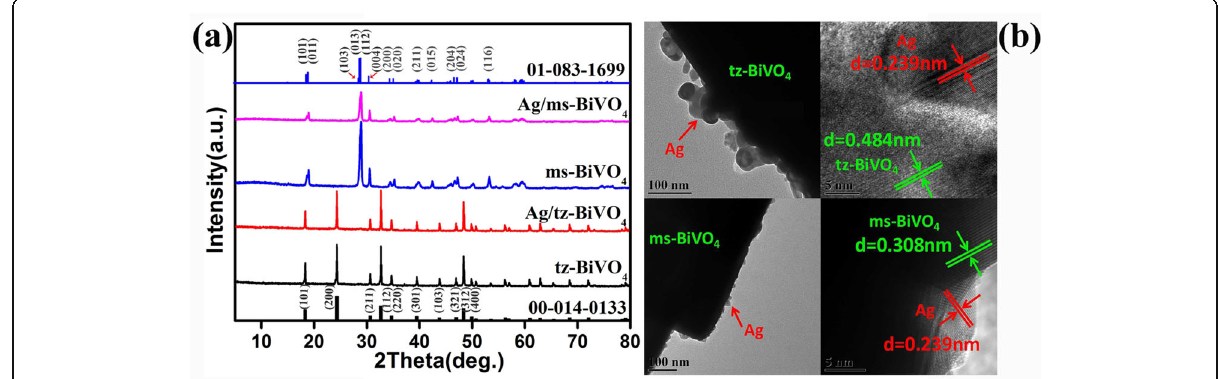
Fig. 1 a XRD patterns of pristine tz-BiVO 4 , Ag/tz-BiVO 4 sample, pristine ms-BiVO 4 , and Ag/ms-BiVO 4 sample. b TEM image of Ag/tz-BiVO 4 , HRTEM of Ag/tz-BiVO 4 , TEM image of Ag/ms-BiVO 4 , and HRTEM of Ag/ms-BiVO